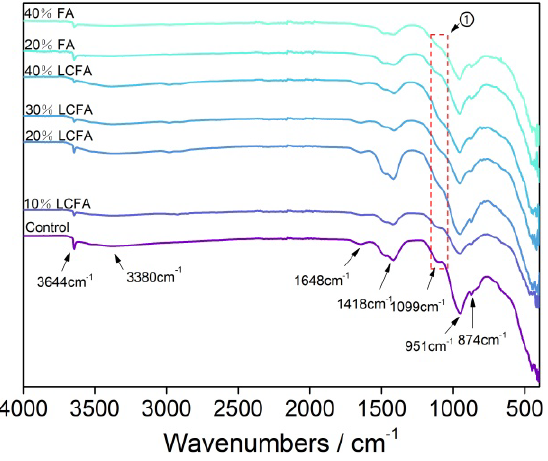
Figure 13. FT-IR curves of OPC − LCFA and OPC − FA samples at 28 days.